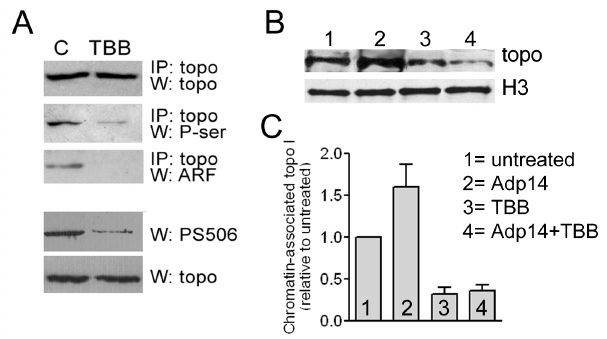
Figure 3. Chromatin association of topo I. (A) Rows 1–3: Topo I IP followed by Western analyses of total topo I, phosphoserine, and ARF was performed before (lane ‘‘C’’) or 2 days after (lane ‘‘TBB’’) treatment of H358 cells with TBB (10 m M for 1 h); rows 4 and 5: Western analyses of PS506 and total topo I in the same starting samples as in rows 1–3. Quantification of band densities indicated that TBB treatment reduced both P-ser and PS506 reactivity by , 80%. (B) Histone H3 chromatin immunoprecipitation (ChIP) of untreated H358 cells (lane 1) or 2 days after treatment with 20 moi Adp14 (lane 2), TBB (10 m M, 1 h; lane 3), or both Adp14 and TBB (lane 4), followed by Western analyses of histone H3 and topo I. (C) The results of four independent ChIP analyses performed as in (B); bars represent the mean and standard deviation of chromatin-associated topo I levels in the treated cells relative to the untreated cells, quantified digitally from band intensities.